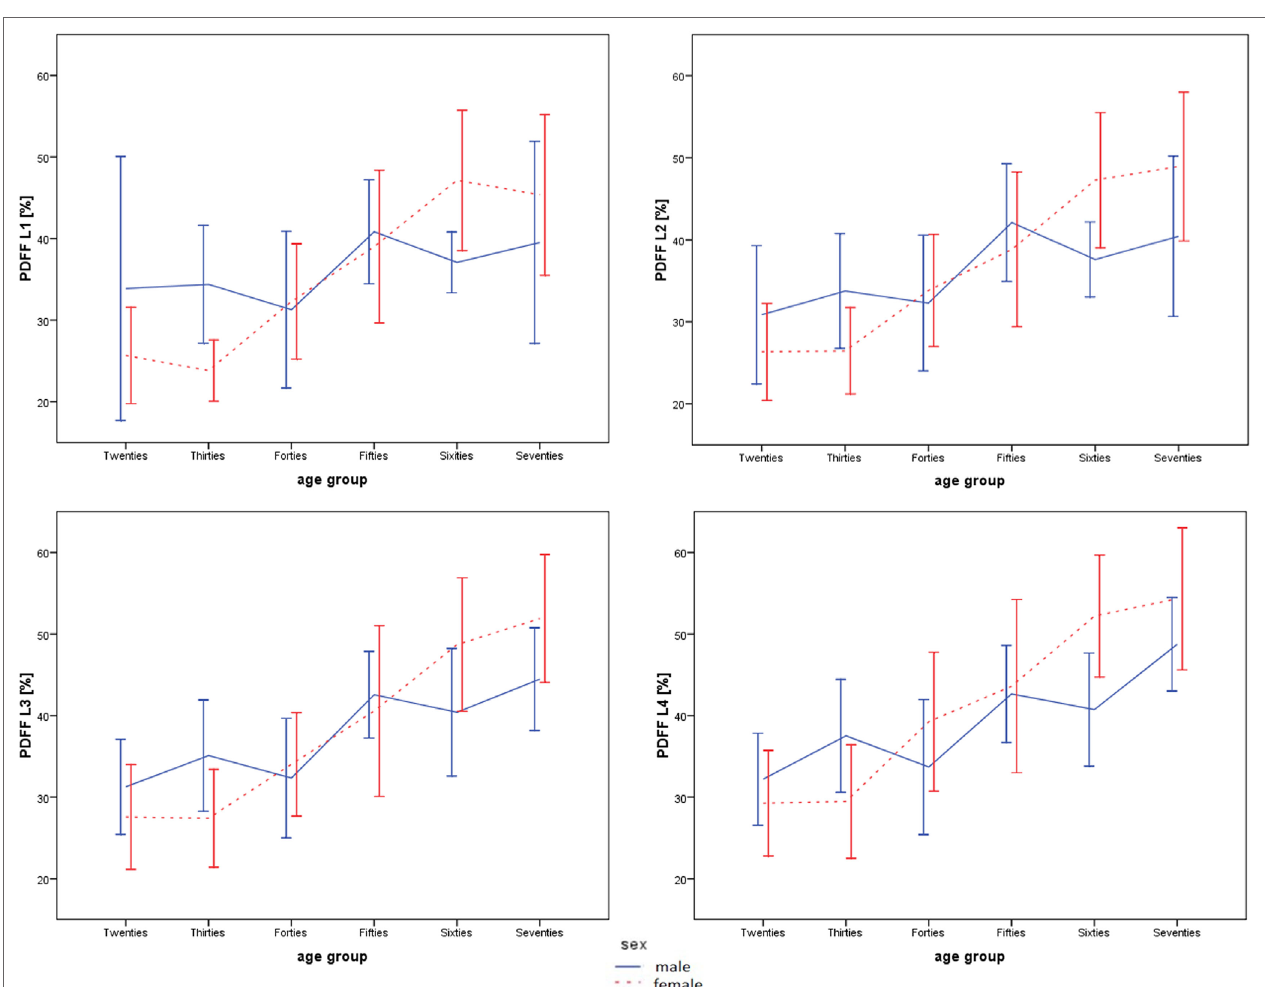
FigUre 2 | Mean and SD of proton density fat fraction (PDFF) values for males (blue/solid) and females (red/dashed) in L1–L4. Note the pronounced age-related fatty bone marrow conversion at lower lumbar vertebral